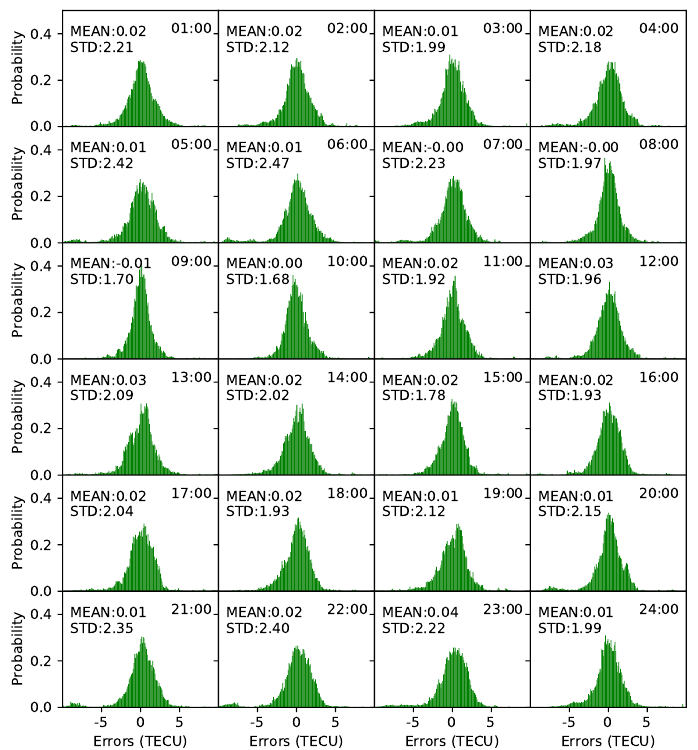
Figure 8. Frequency distribution histograms of model residuals on DOY 135, 2018.